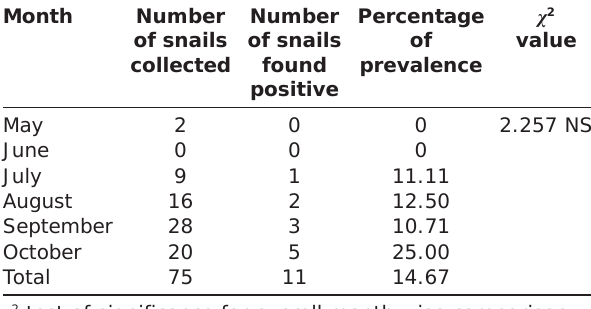
Table-3: Overall month wise prevalence of Gyraulus spp. having infective stages of parasites in and around Ranchi. Month